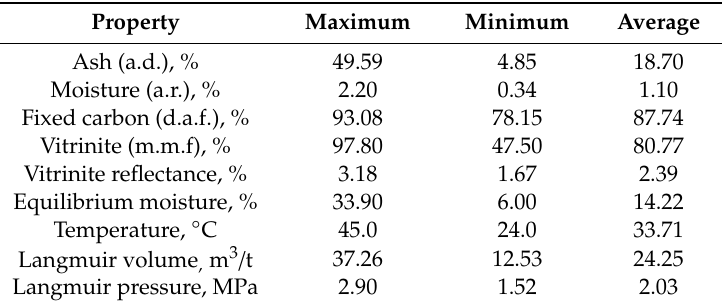
Figure 2. Stratigraphy of the coal-bearing strata in the study area. Reprint with permission [24]; 2011, Elsevier Ltd. Table 1. Summary of the experimental